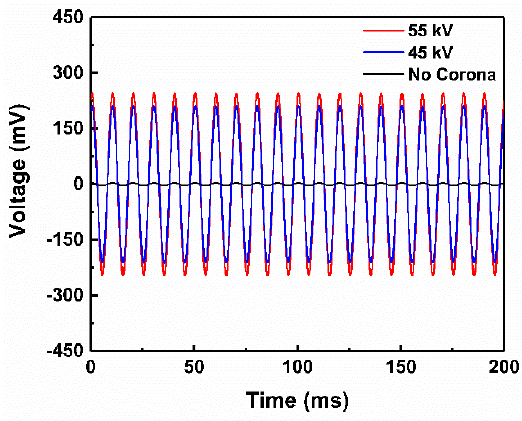
Figure 2. Voltage measurement output from a foam sample poled at 0, 45, and 55 kV and excited by shaker. Table 1. Piezoelectric coefficients of the foam samples without and with poling, before and after annealing. Corona Voltage